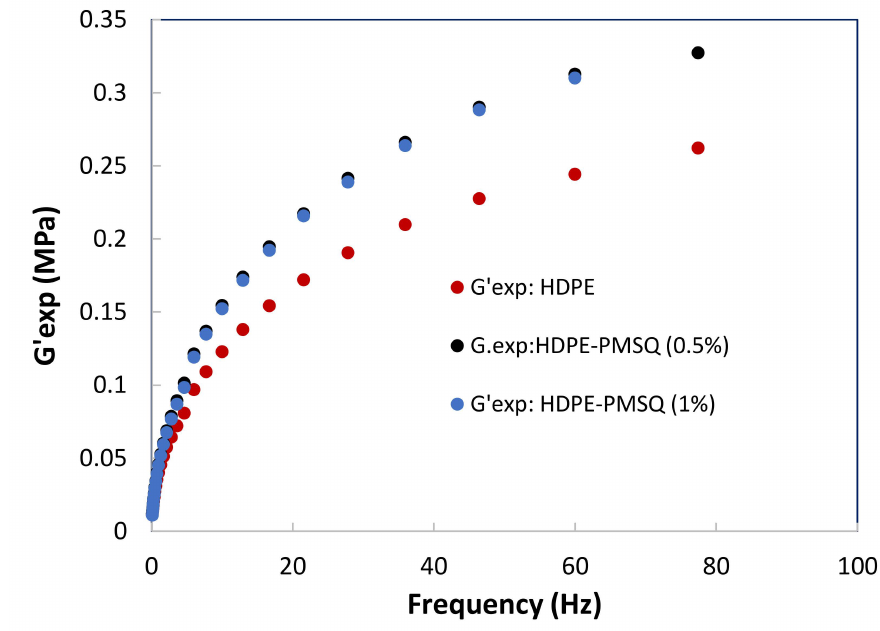
Figure 2. Experimental results of the storage moduli (G’) as a function of the PMSQ nanoparti- cles